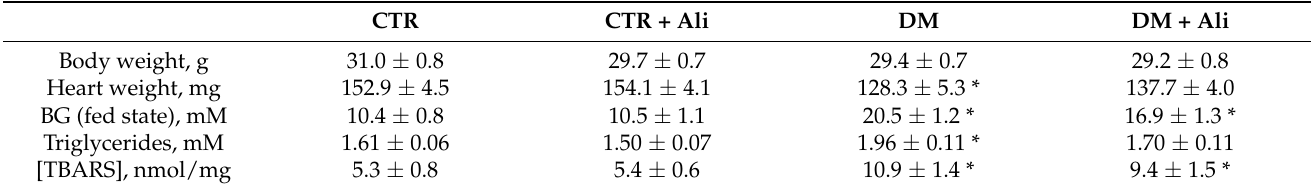
Table 2. Animal weights and biochemical characteristics of the blood in the experimental groups.